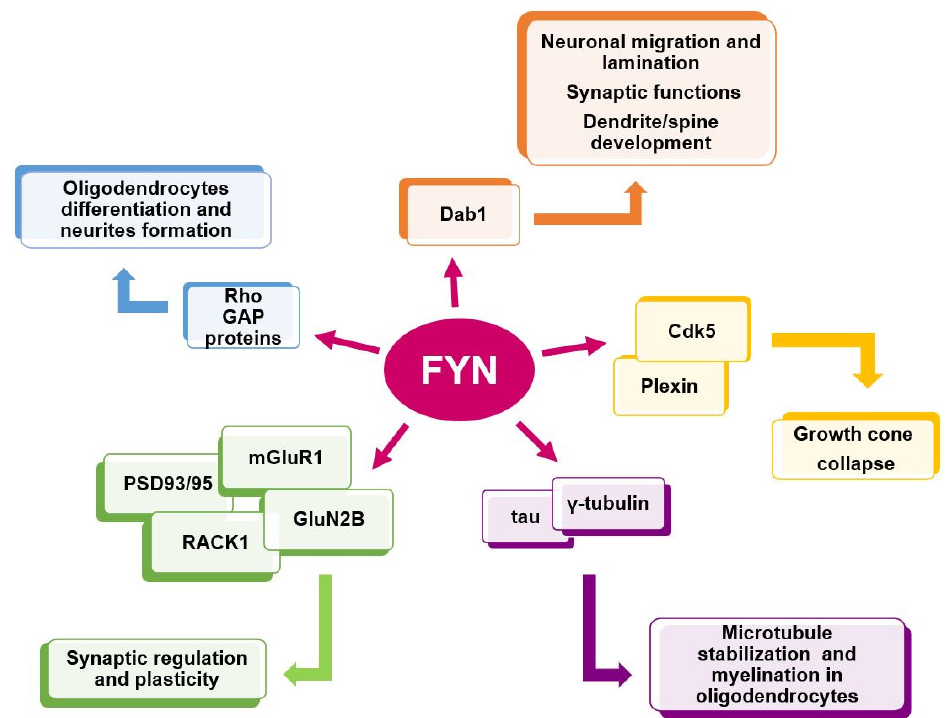
Figure 3. Fyn functions in the brain. Adapted from Schenone et al. (2011) [8] .